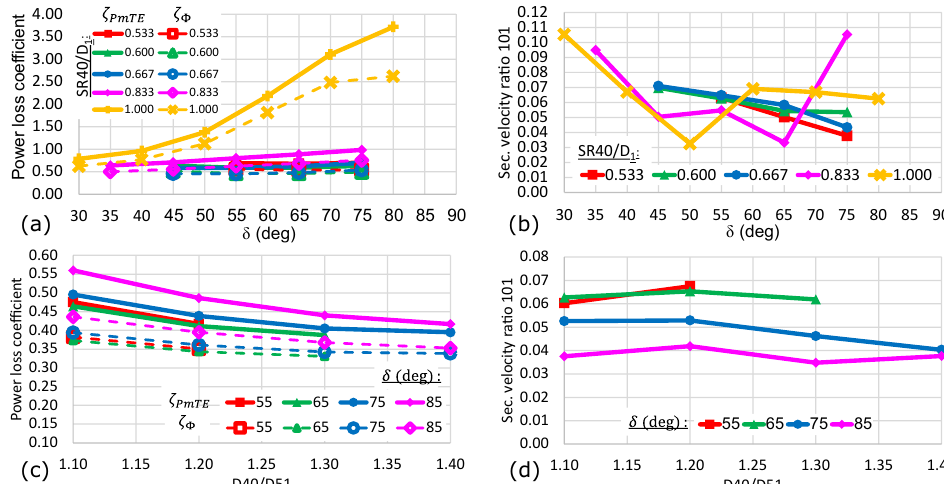
Figure 8. Line plots of the power loss coefficients and secondary velocity ratios of the model with spherical manifold. Charts ( a , b ) show the effect of a variation of the deviation angle δ for five different sphere radii SR 40 / D 1 for a configuration without a frustum. Charts ( c , d ) show the effect of a variation of the frustum diameter ratio D 40 / D 51 for different deviation angles δ and a fixed sphere radius of SR 40 / D 1 =